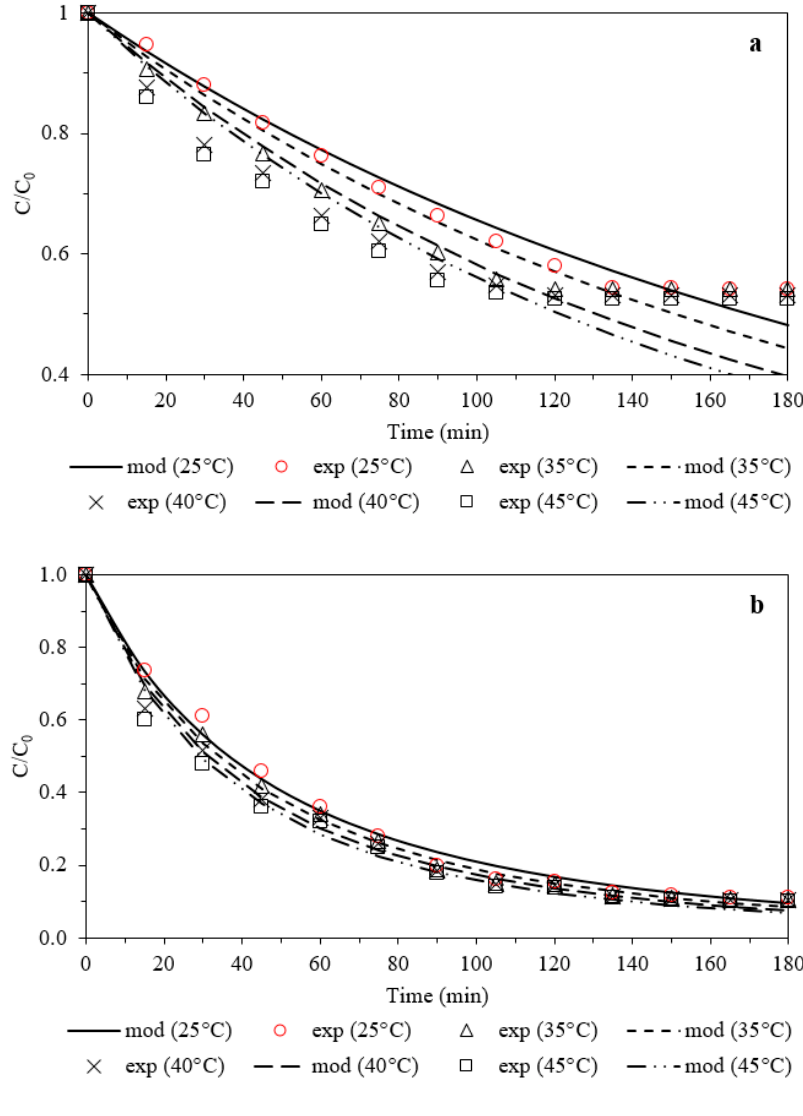
Figure 5. OMW ( a ) and synthetic phenol solution ( b ) kinetic photodegradation results and modeling at different T values (T = 25, 35, 40, and 45 °C; initial OMW COD = 9.4 g L − 1 ; synthetic solution initial concentration = 25 mg L − 1 ; impeller rotational velocity = 200 rpm).